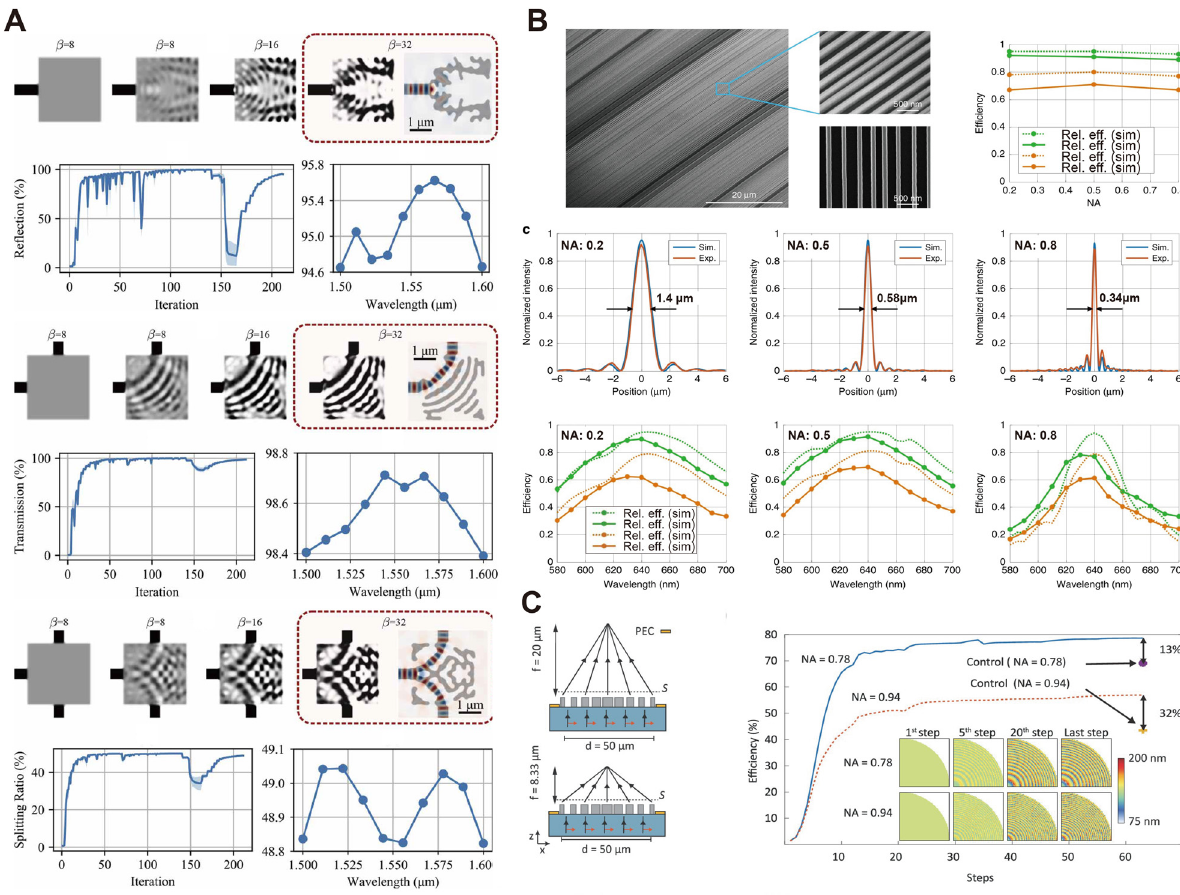
Figure 2: Topology optimization in nanophotonic inverse design (A) design-rule-constrained nanophotonic devices optimized with foundry design rule checks. The panels depict the optimization process and efficiency of top: mirror, middle: bend and bottom: T-splitter. Adapted from [33]. (B) High-NA, high-efficiency metalenses designed with linearized topology optimization. Top left: SEM images of the fabricated metalenses. Top right: experimental and simulated efficiencies of metalenses with NAs of 0.2, 0.5, and 0.8, respectively. Middle row: measured intensity at the focal planes of the designed metalenses. Bottom row: transmission efficiencies in the wavelength range 580–700 nm of the designed metalenses. Adapted from [31]. (C) Two dielectric metalenses with NA = 0.78 and 0.94, respectively (left) and the corresponding focusing efficiencies during the optimization process (right). Adapted from